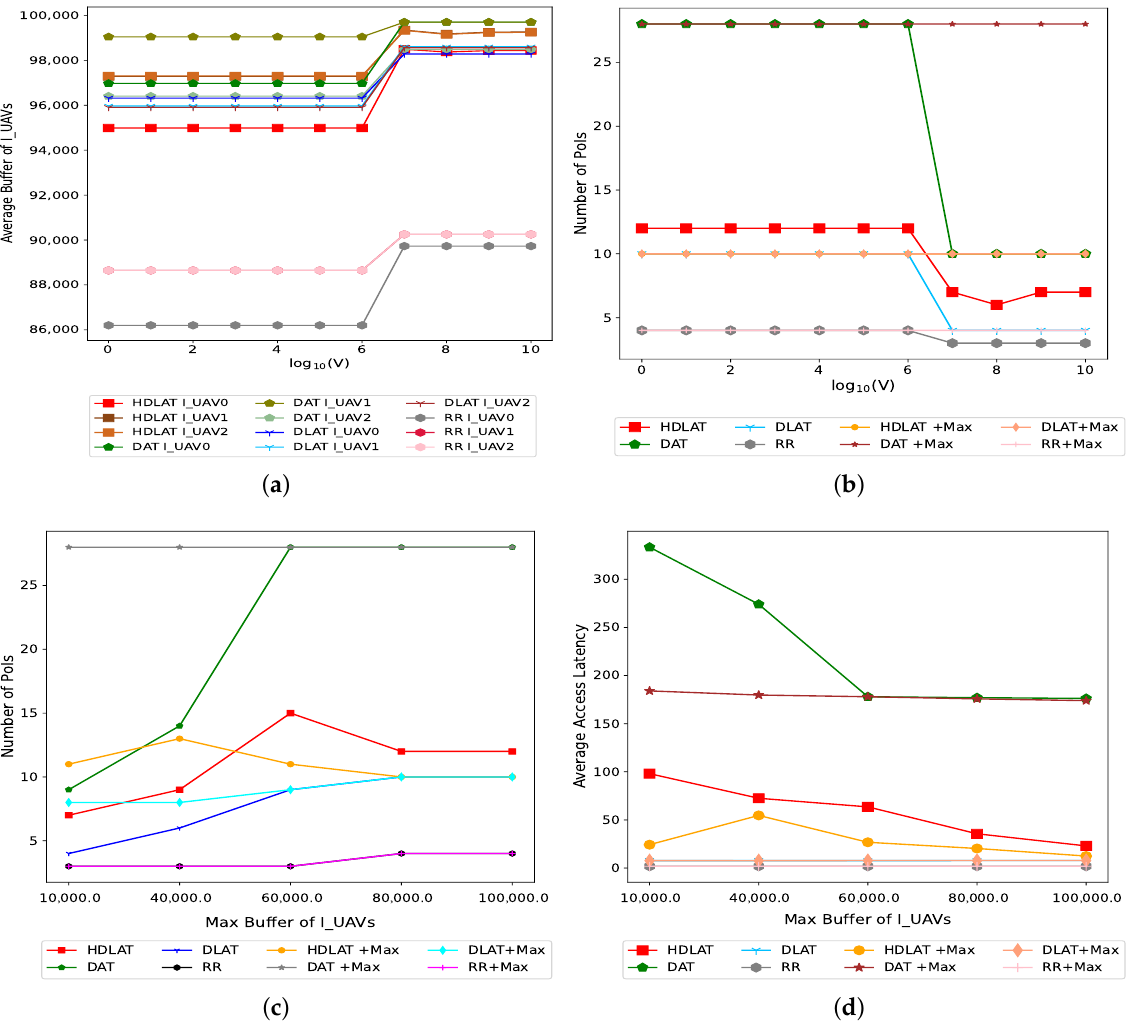
Figure 4. Various Results of the System. ( a ) Analysis of Average Buffer of I _ UAV . ( b ) Analysis of Total Number of PoIs Covered. ( c ) Analysis of Total Number of PoIs Covered and Max Buffer of I _ UAVs . ( d ) Analysis of Average Access Latency and Max Buffer of I _ UAVs